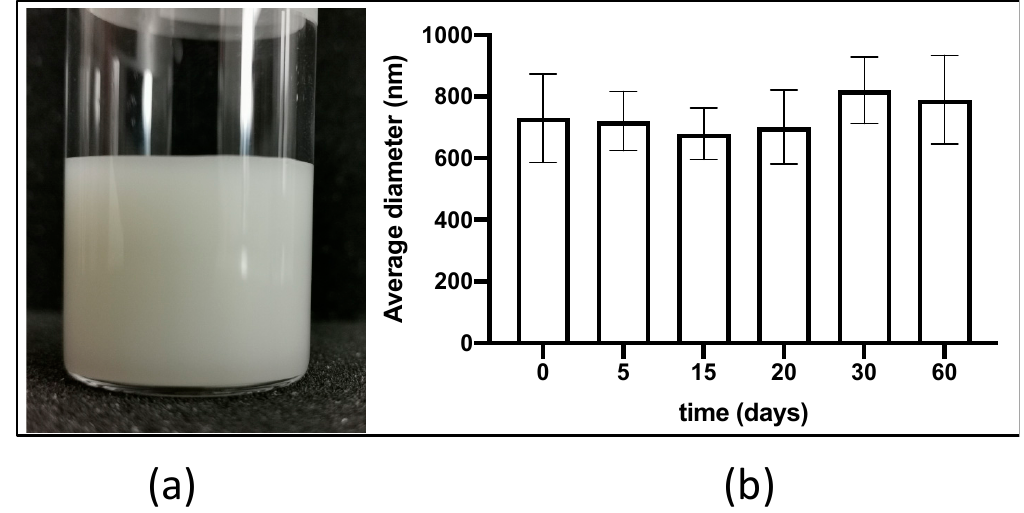
Figure 1. Dispersion macroscopic appearance ( a ) and mean size during time ( b ) of LHC. Data are the mean of five independent determinations on different aliquots of the dispersion ± SD.